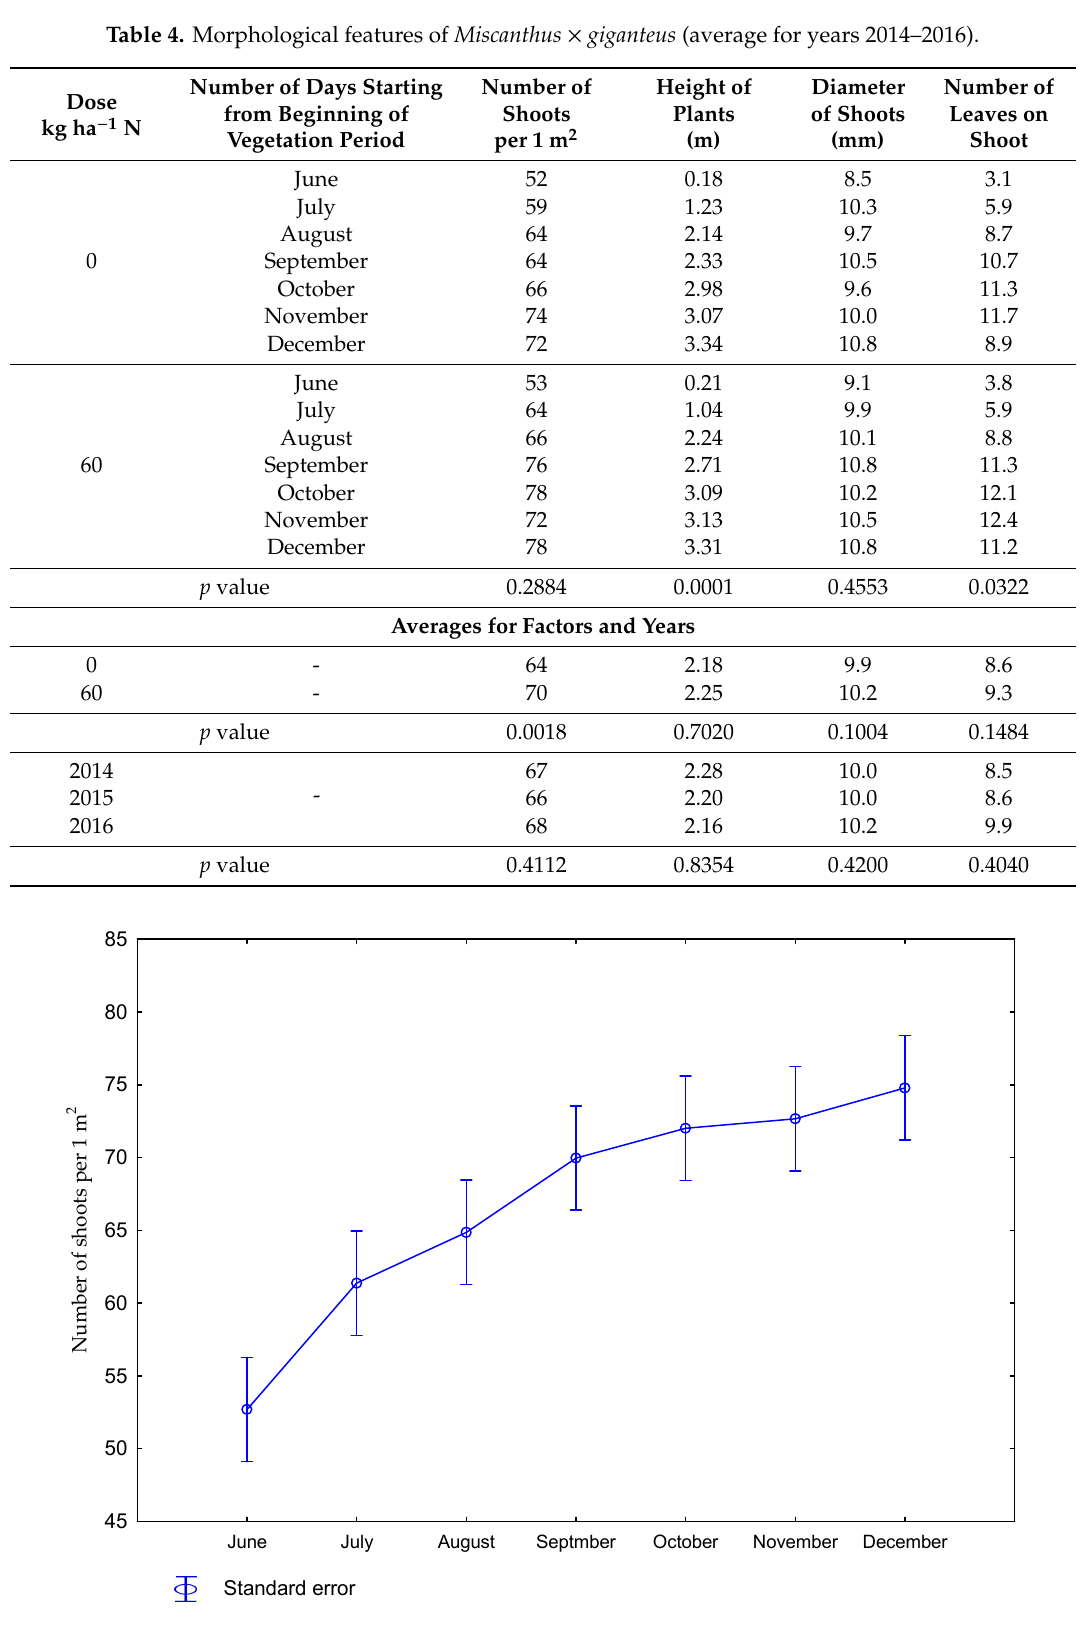
Figure 1. The number of shoots during the vegetation period in the years 2014–2016 (average for years).